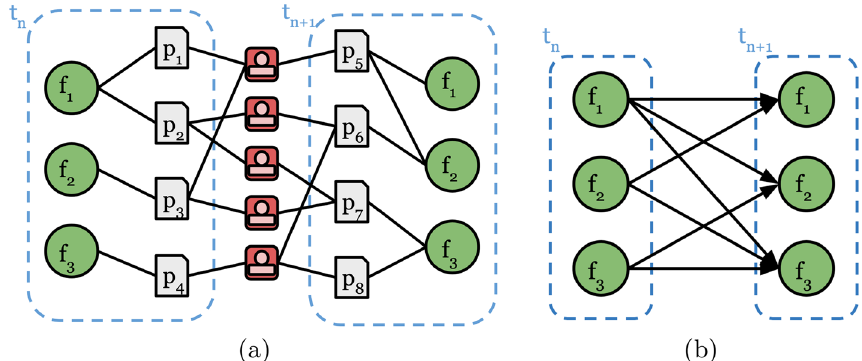
Fig. 2 Illustrative example of a temporal Field of Study (FoS) network, involving two steps: a creation of a heterogeneous network of authors and fields; b projection to a directed network of